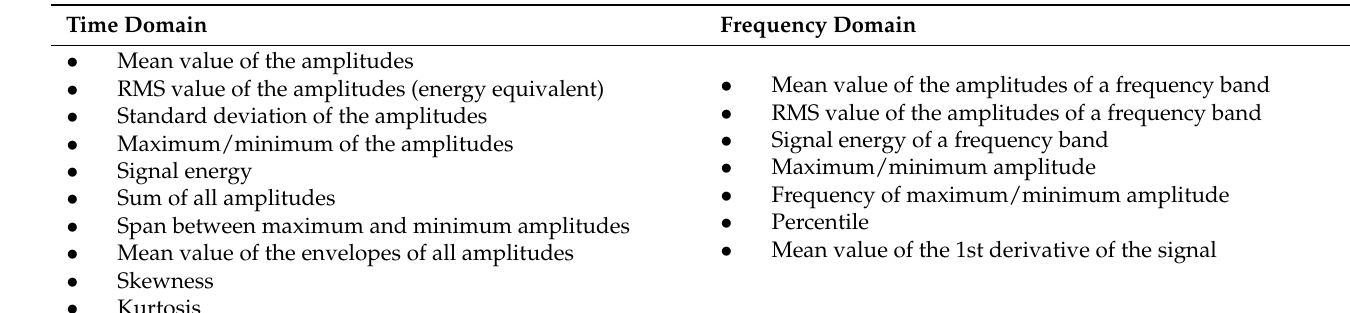
Table 2. Selection of possible features in the time and frequency domain according to Mikut